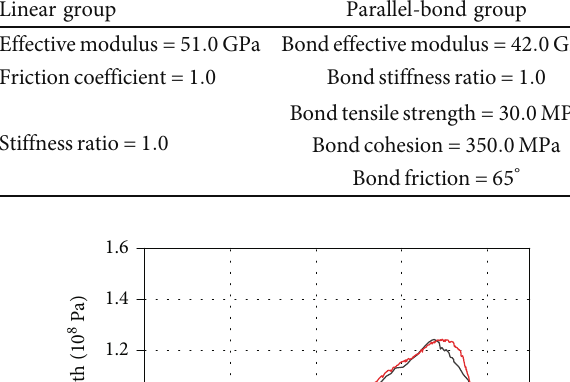
Table 1: Microscopic parameters of sandstone [31]. Linear group